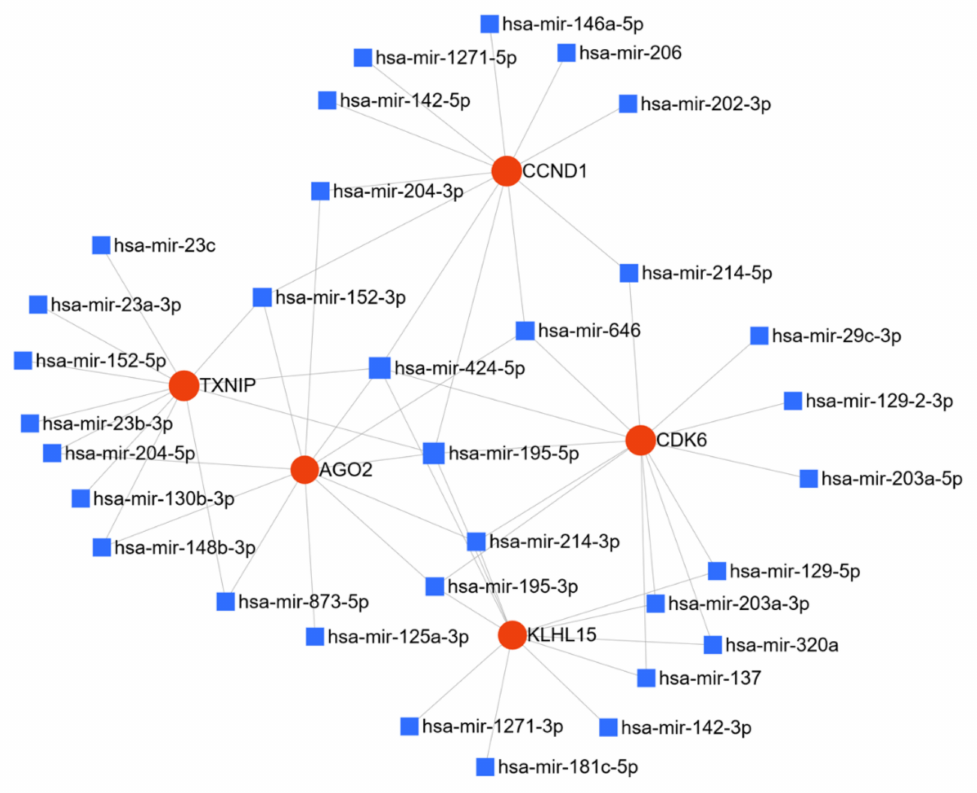
Figure 7. Network of downregulated miR in endometrial cancer: miR deregulated in endometrial cancer were searched in the PubMed database using IRIDESCENT. The network of downregulated miR generated using miRNET (degree filter cutoff 10) is shown. The blue squares represent miR, and the red dots represent target genes of these miRs.